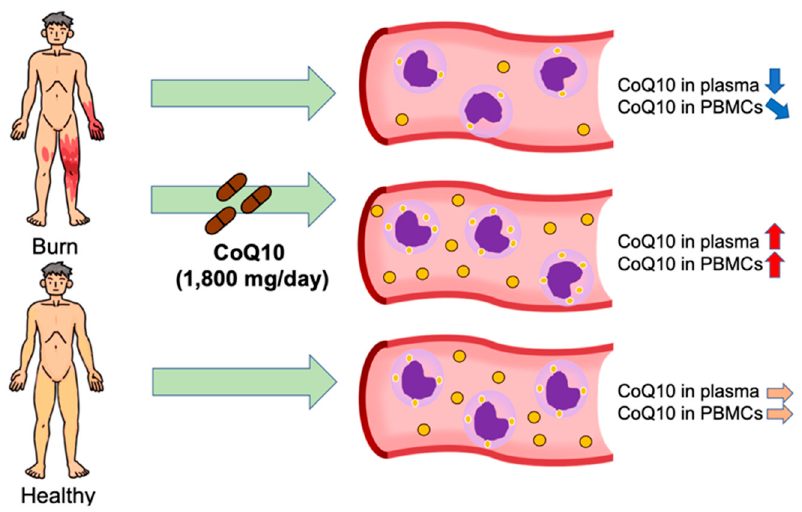
Figure 7. CoQ10 status in burn patients and effects of CoQ10 supplementation. Plasma CoQ10 concentrations and CoQ10 content in peripheral blood mononuclear cells (PBMCs) were lower in burn patients compared with healthy volunteers. CoQ10 supplementation significantly increased plasma CoQ10 concentrations and CoQ10 content in PBMCs in burn patients.